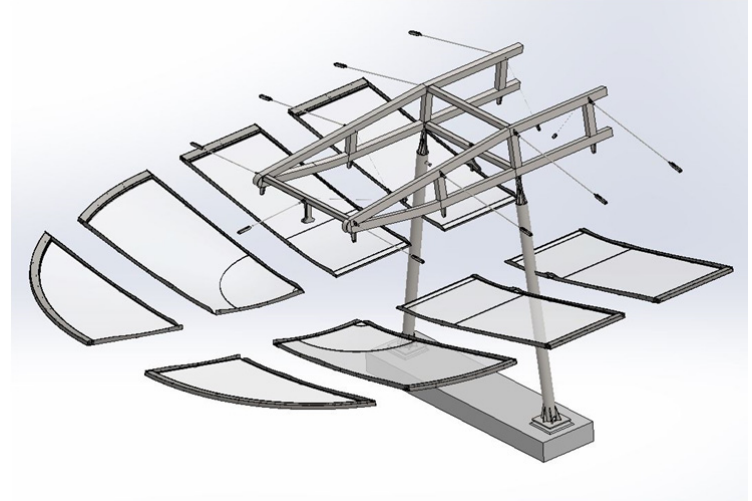
Fig. 3 Regular and front end glass